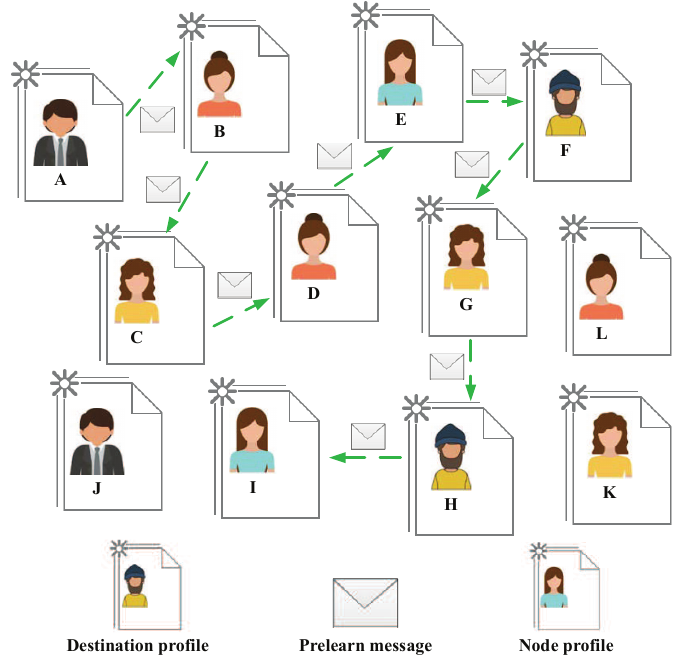
Figure 2. The routing process diagram of Predict